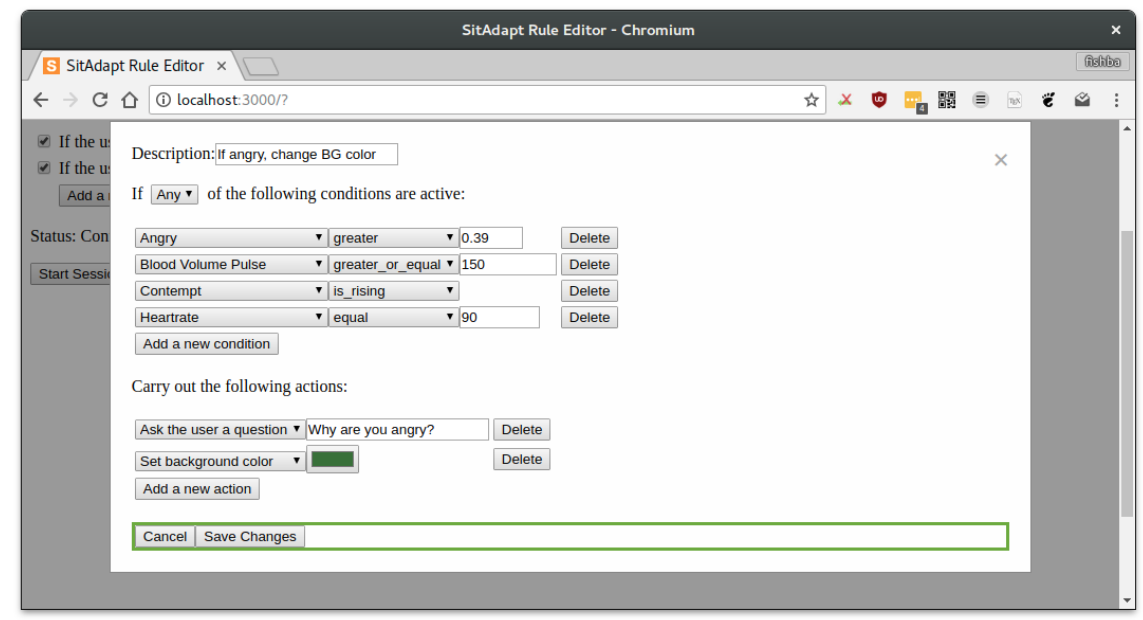
Figure 2. SitAdapt 2.0 Rule Editor